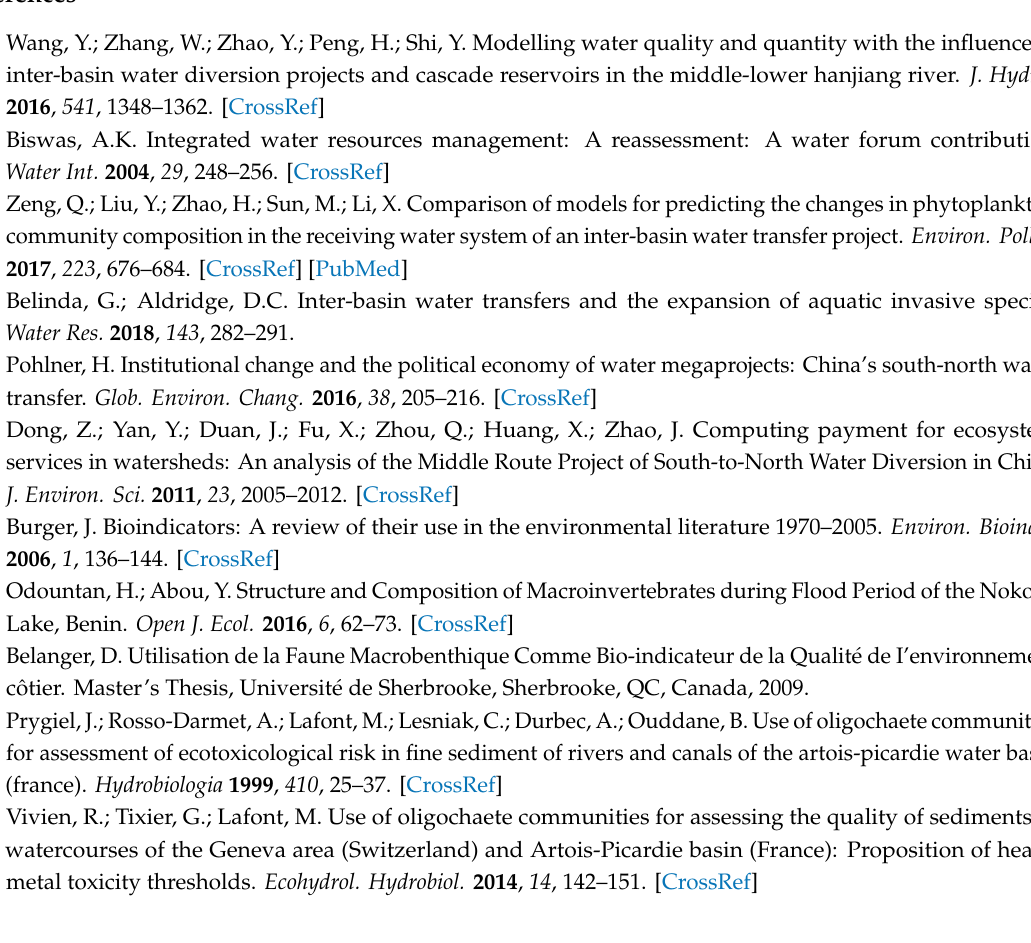
IV from Randomized